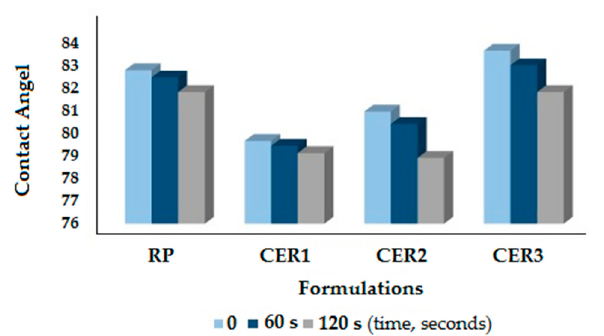
ff erent contact